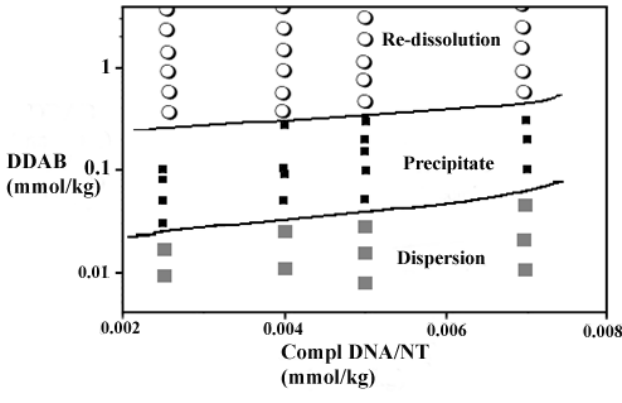
Figure 5. Plot of DDAB vs. 1/1 ss-DNA/CNT concentration, at 25.0 °C. Precipitation occurs between the two